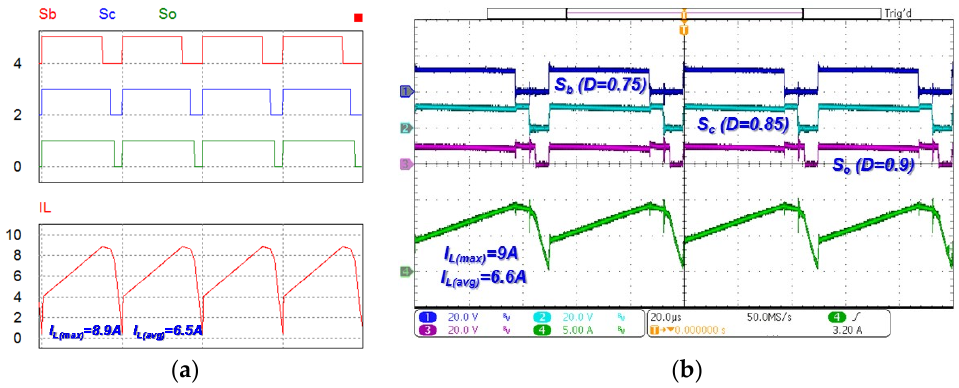
Figure 11. Gate driving signal and inductor current waveforms in the battery charging mode: ( a ) by